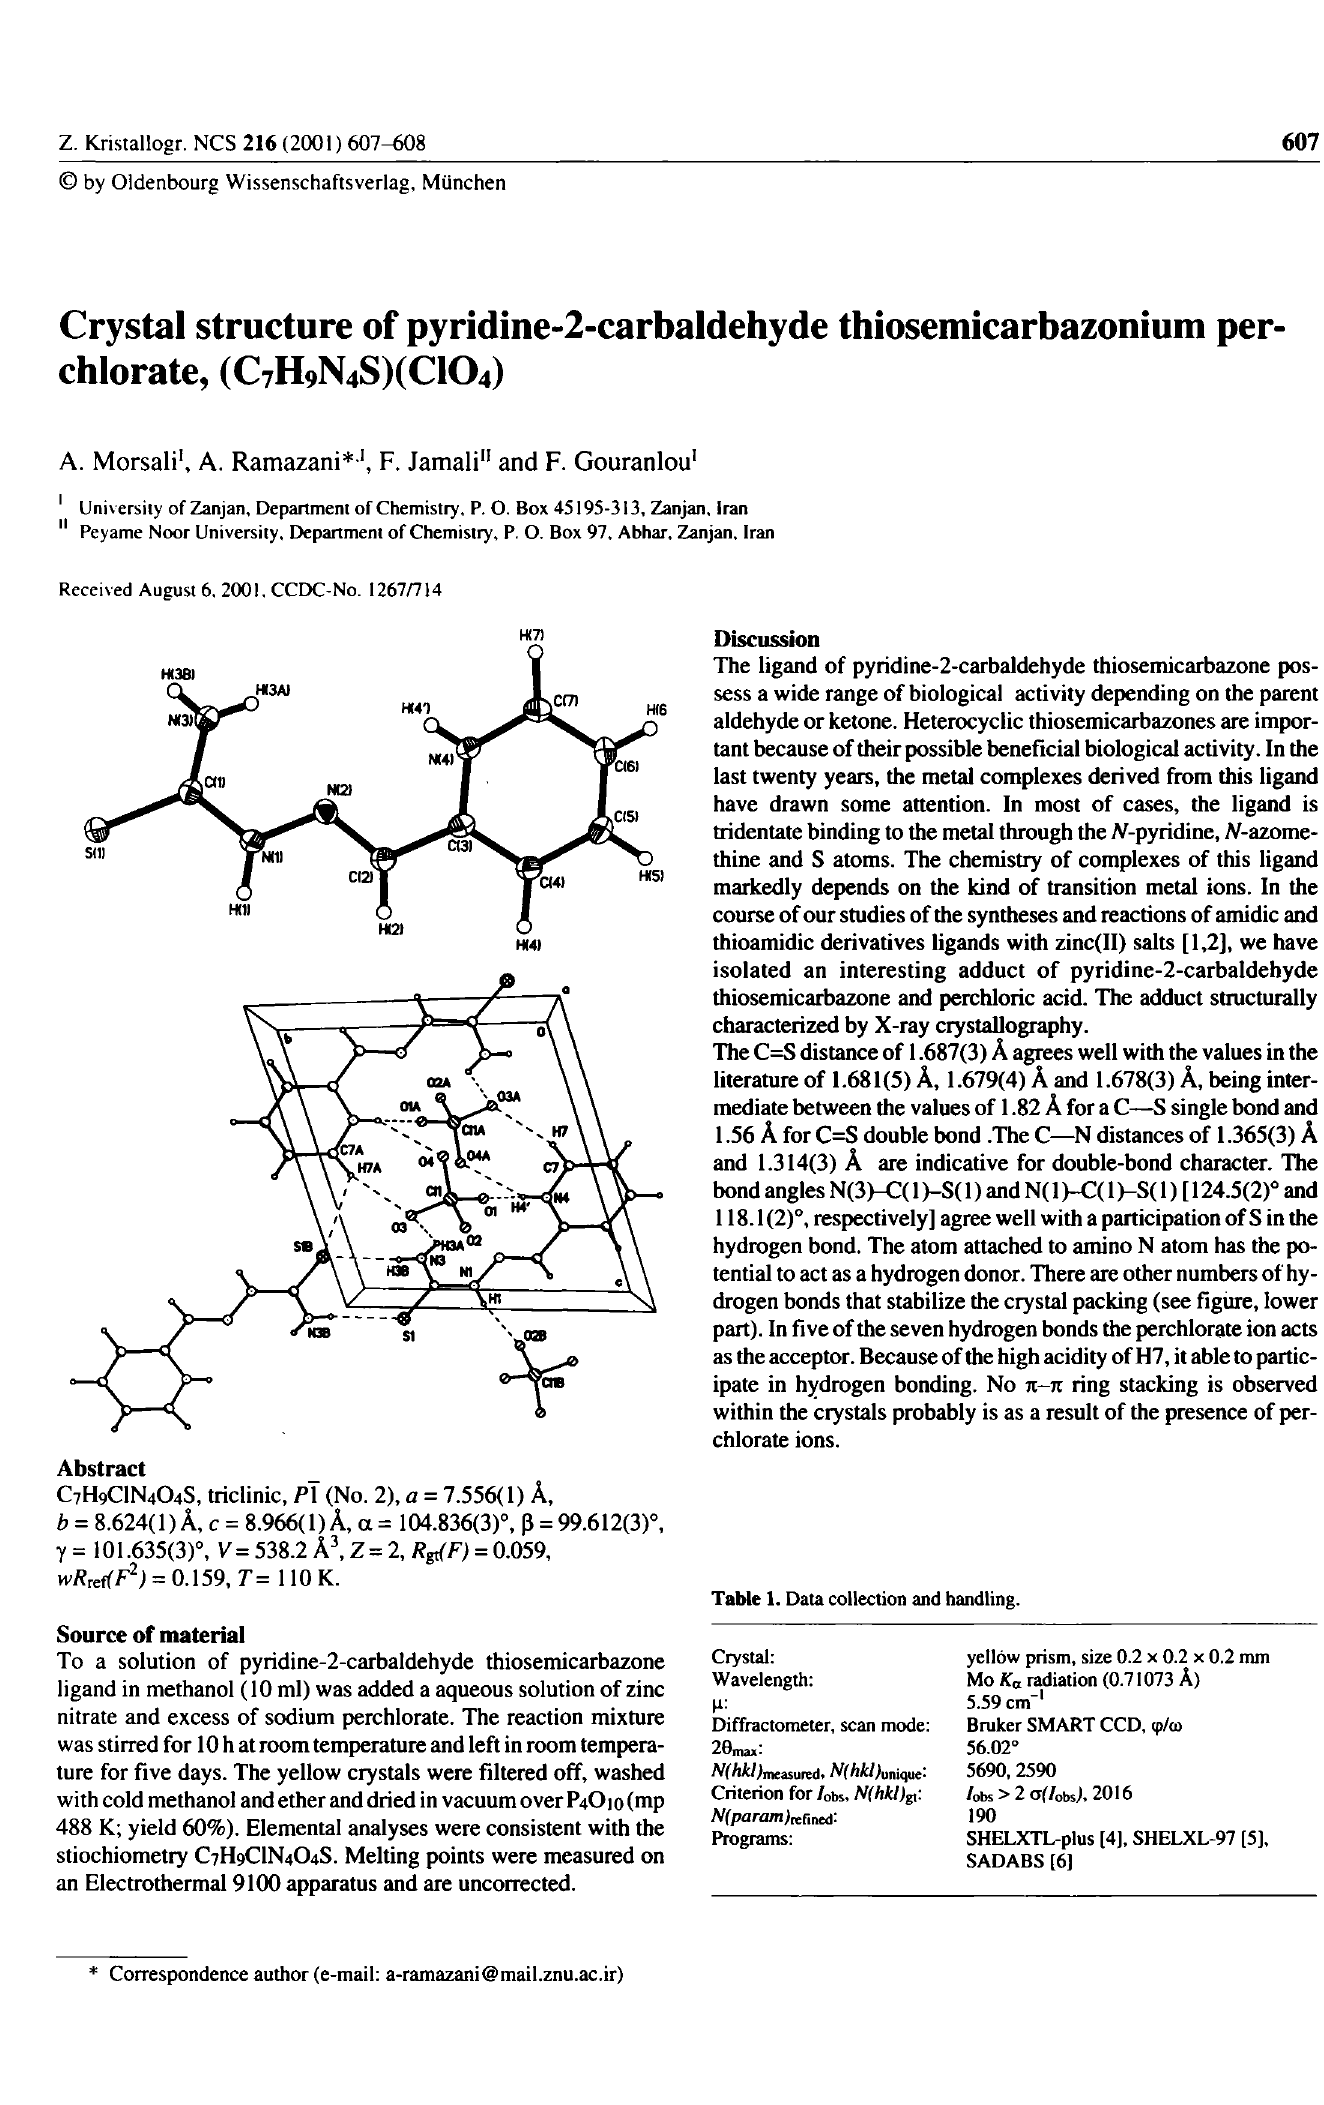
Table 1. Data collection and handling.